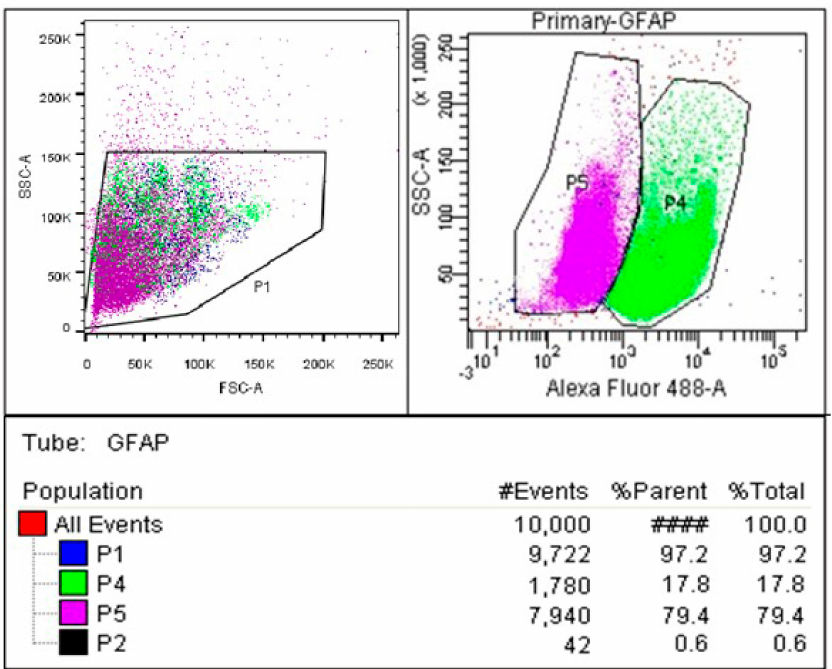
Figure 1. Glial fibrillary acidic protein (GFAP) immunophenotyping to determine the purity of astrocyte culture. Cultures were stained with GFAP antibodies tagged with FITC (Fluorescein Isothiocyanate) and analyzed on a flow cytometer. P1 shows the population of cells; P2 shows the debris cells which are located in the lower left-hand side of scatter plots; P4 shows the primary astrocyte cells; P5 shows the contaminated cells. The plot shows that 79.4% of cells in the culture are